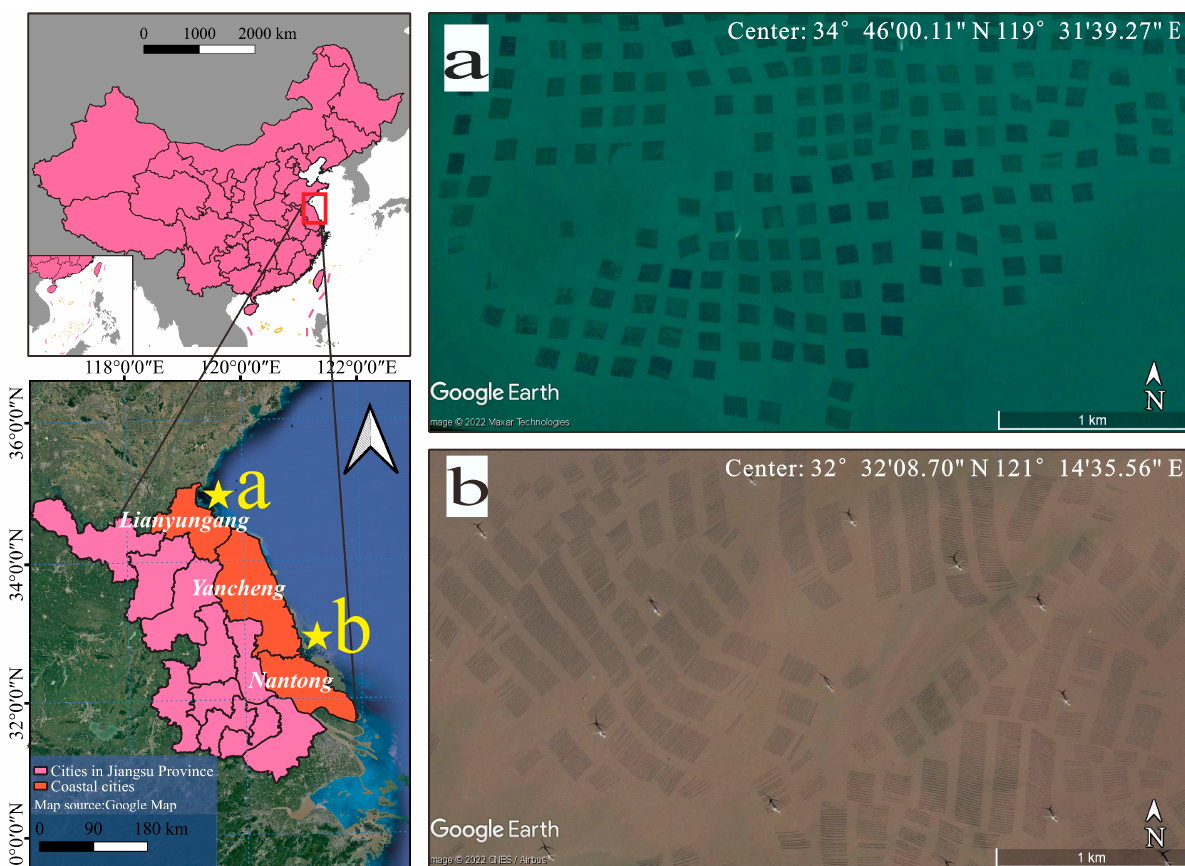
Figure 1. The scope of the study area ( Left ) and seaweed aquaculture on Google Earth Pro ( Right , a , b ).